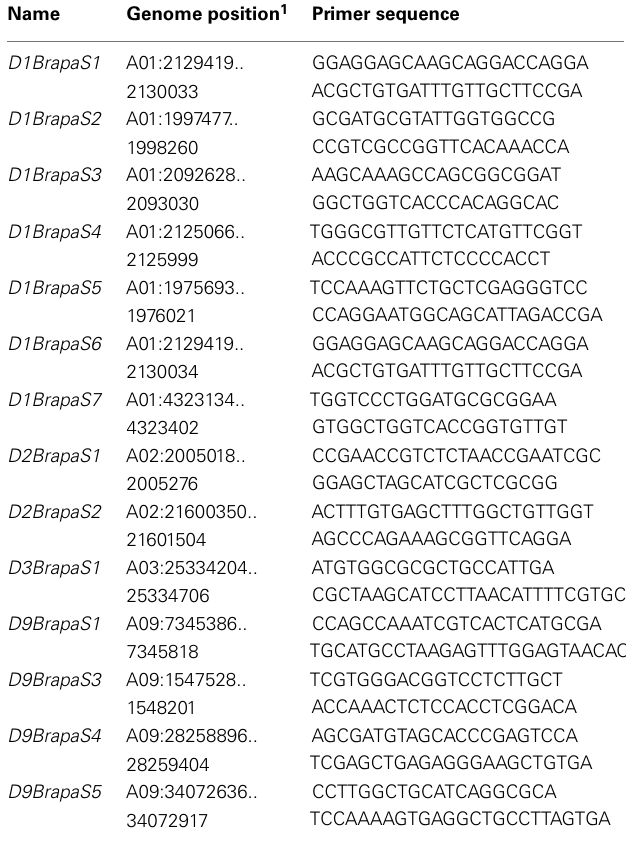
Table 1 |Variable number tandem repeat-type markers for rapid cycling Brassica rapa.